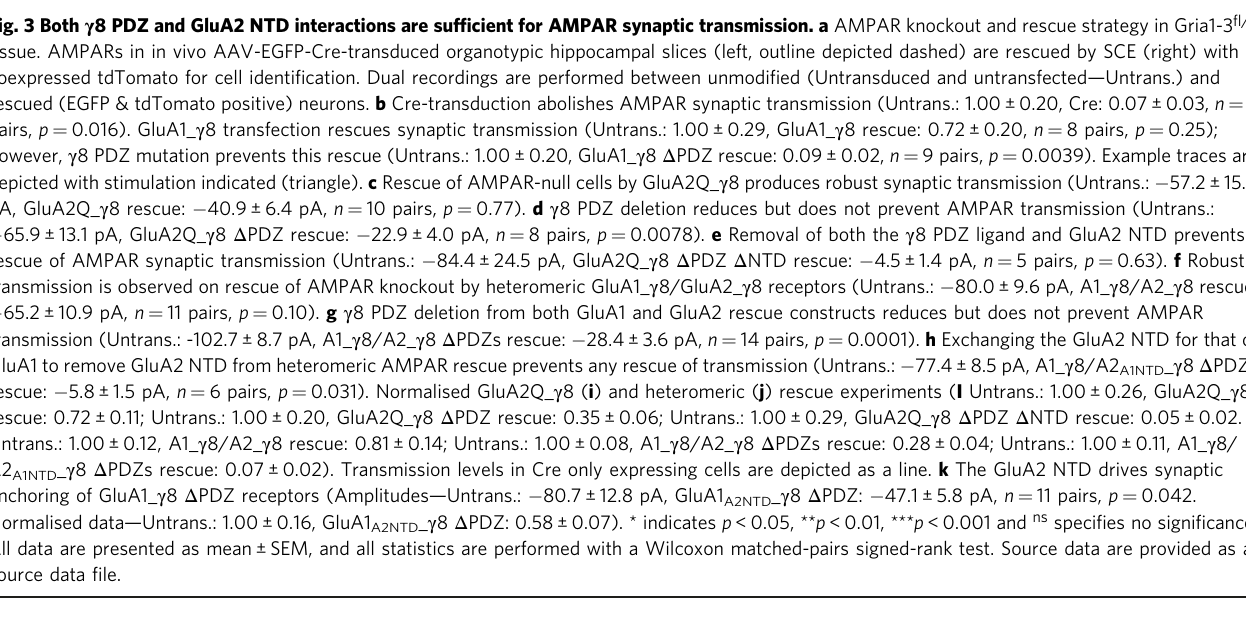
Fig. 3 Both γ 8 PDZ and GluA2 NTD interactions are suf fi cient for AMPAR synaptic transmission. a AMPAR knockout and rescue strategy in Gria1-3 fl / fl tissue. AMPARs in in vivo AAV-EGFP-Cre-transduced organotypic hippocampal slices (left, outline depicted dashed) are rescued by SCE (right) with coexpressed tdTomato for cell identi fi cation. Dual recordings are performed between unmodi fi ed (Untransduced and untransfected — Untrans.)